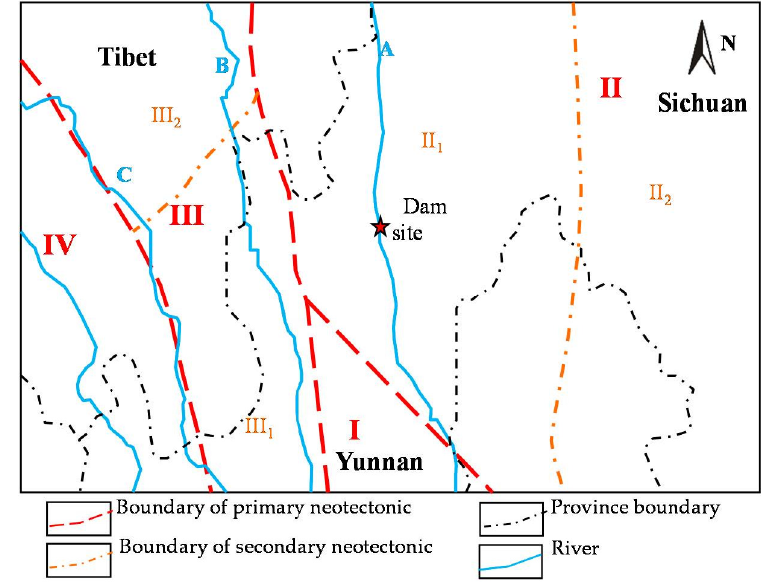
Figure 2. Regional neotectonic movement zoning map: I: Zhongdian-Yulong-jokul rapid uplift zone; II: The western of Sichuan rapid uplift zone; II 1 : Gajinjokul strong rapid uplift zone; II 2 : Daocheng-Gongga mountain tilted uplift zone; III: Qiangtang-Changdu rapid uplift zone; III 1 : Bijiang-Baoshan tilted uplift zone; III 2 : Changdu fault block uplift zone; IV: Nianqingtanggula-Gaoligong mountain fault block uplift zone; A: The Jinsha River; B: The Lancang River, C: The Nu River.